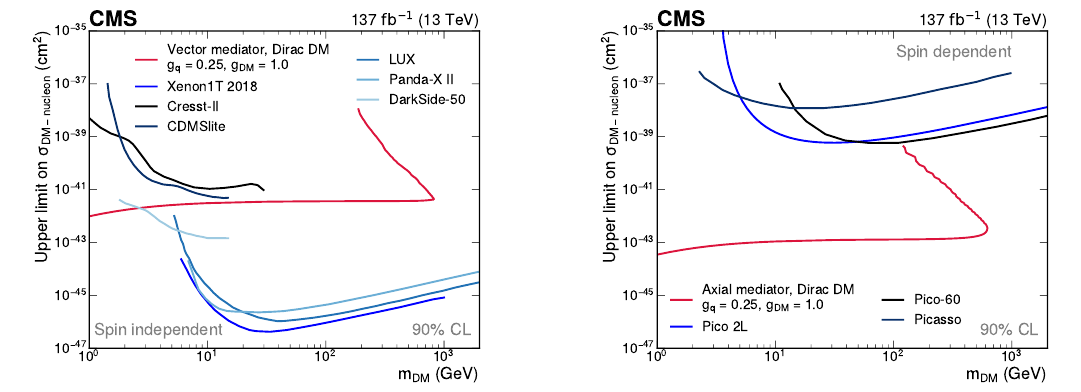
Figure 22 . Comparison of the simplified model constraints from this search (red line) to re- sults from direct-detection experiments (blue lines). The comparison is shown separately for the vector (left) and axial-vector (right) mediators, which translate into spin-independent and spin- dependent DM-nucleon couplings, respectively. In the case of spin-independent couplings, results from CRESST-II [90], CDMSlite [91], LUX [92], DarkSide-50 [93], XENON1T [94], and Panda-X II [95] are shown for comparison. For spin-dependent couplings, PICO-2L [96], PICASSO [97], and PICO-60 [98] limits are